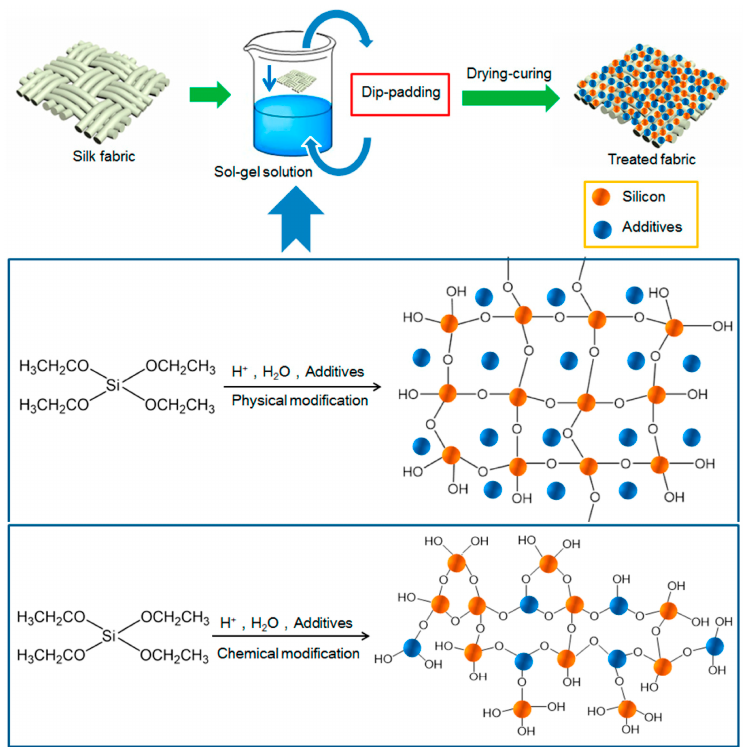
Figure 13. Schematic approach of sol–gel dip-padding to functionalize textile fabrics. Reproduced from MDPI Ref. [34].